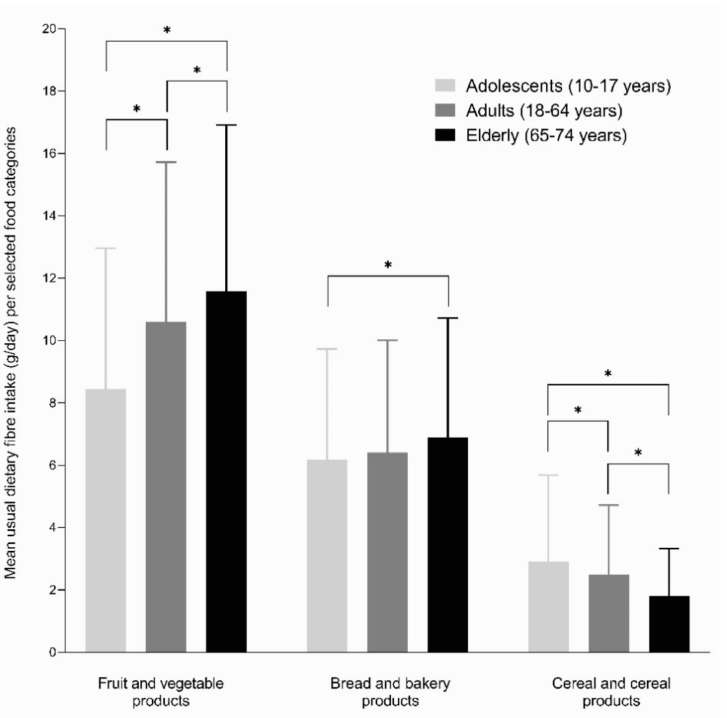
Figure 1. Mean usual dietary fibre intakes (g/day) from selected food categories among different age groups. The symbol * denotes a trend in the